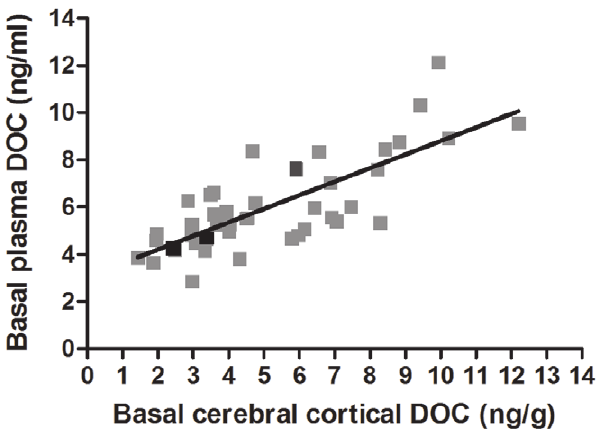
Figure 2. Correlation between cerebral cortical vs. plasma basal DOC levels across the BXD strains. DOC levels are expressed in ng/g (cerebral cortex) or ng/ml (plasma). Gray squares represent BXD strains, black squares are C57BL/6J (B6) and DBA/2J (D2) strains and dark gray square is the B6D2 F1 hybrid. Pearson r =0.78, p , 0.0001; Spearman r =0.74, p , 0.0001; n =43.